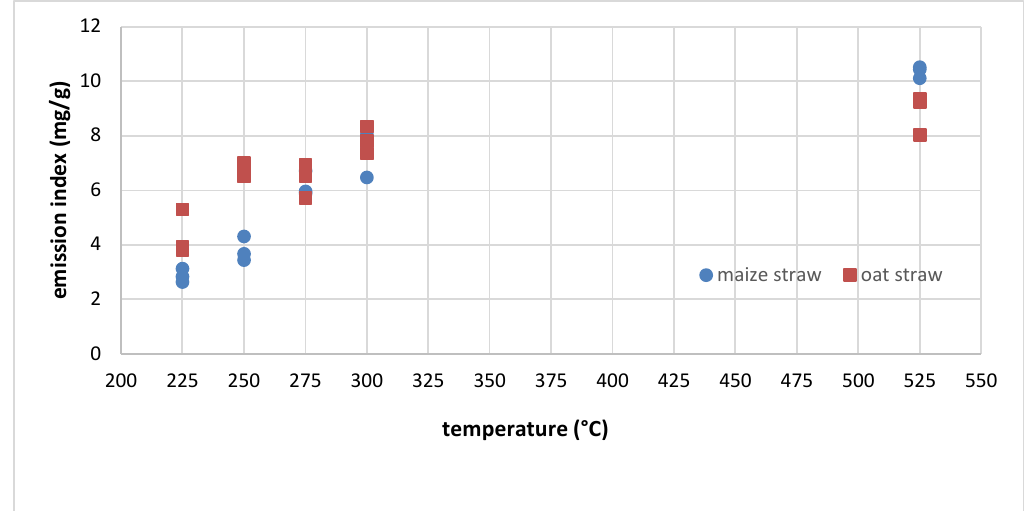
Figure 21. Emission index for maize and oat straw torrefaction process using electrical furnace.